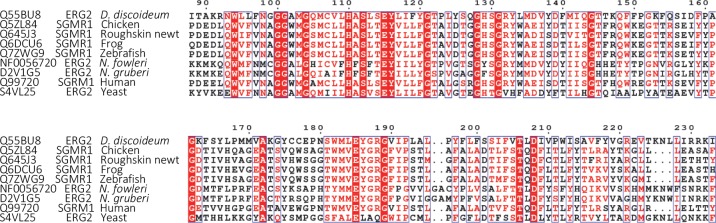
Sequence alignments between the catalytic domain of sterol Δ8−Δ7 -isomerase (ERG2) and a ligand binding site of non-opioid σ1 receptor (SGMR1) demonstrate high sequence similarity.Accession numbers in UniProt or AmoebaDB are provided for each sequence. Numbering is according to the Dictyostelium discoideum ERG2 sequence.